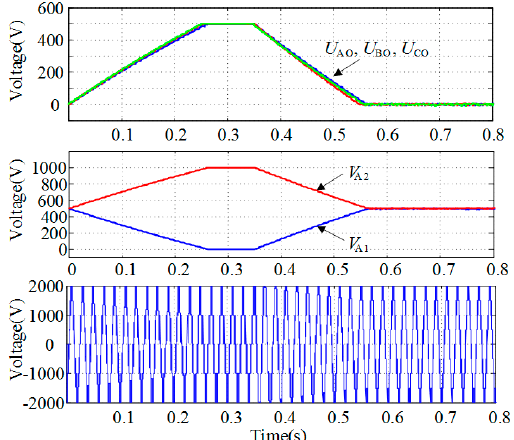
Figure 11. The simulation waveform of dynamic performance. Figure 9. The simulation waveform of dynamic performance. Figure 9. The simulation waveform of dynamic performance.